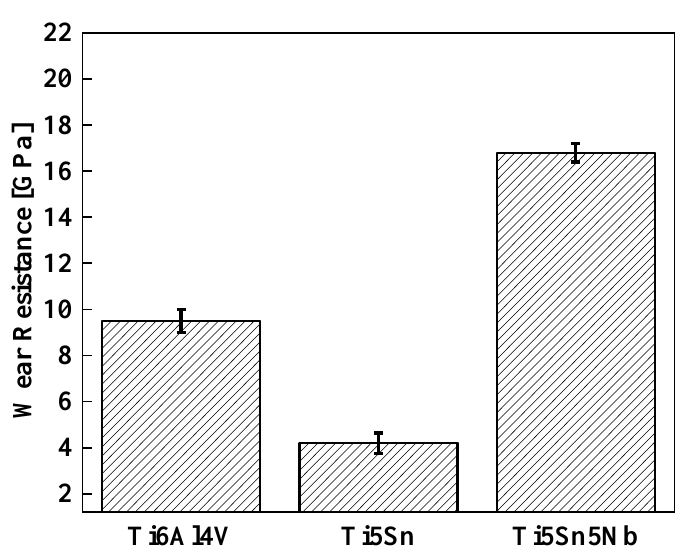
Figure 10. Wear resistance of the Ti-based alloys at room